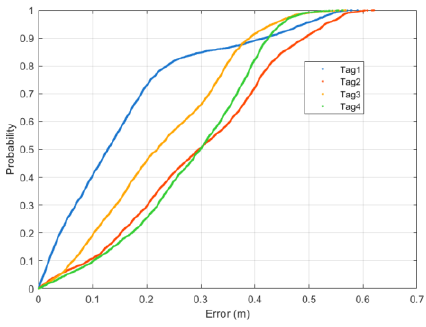
Figure 8. CDF of position estimations